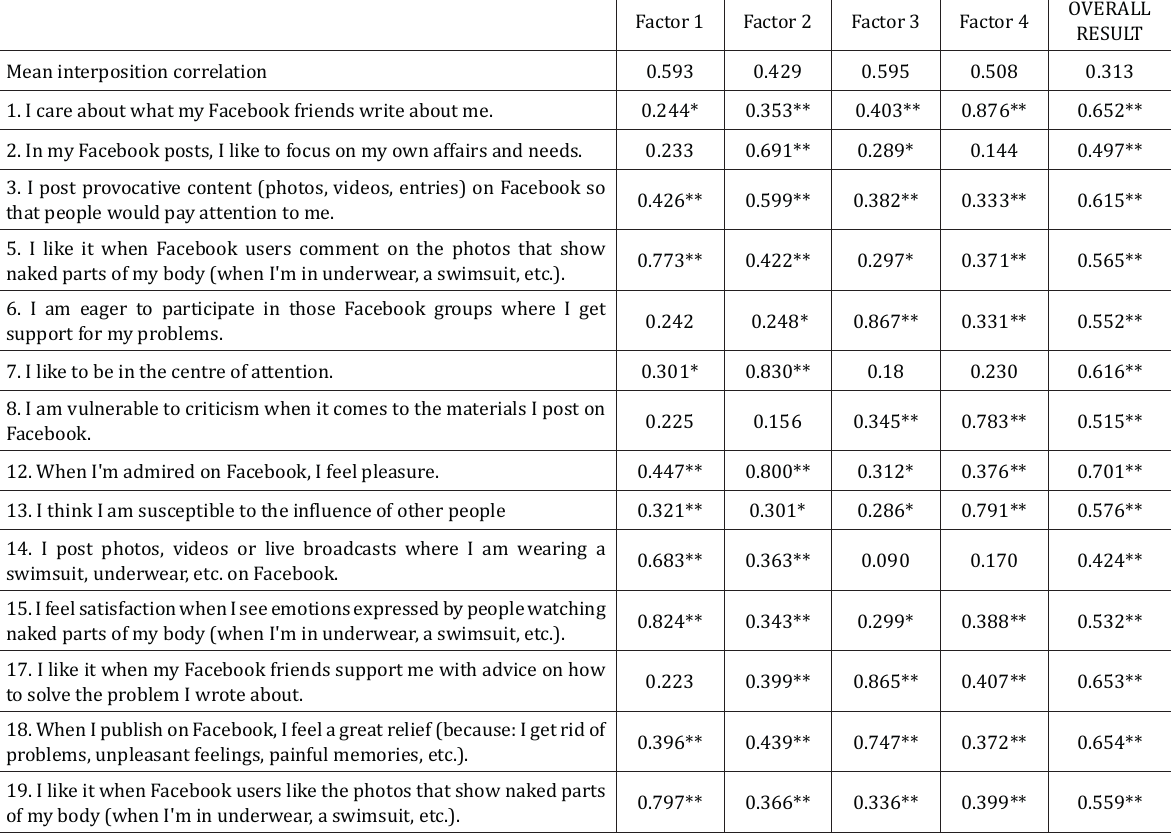
Table 3. The analysis of the correlation of the items with the identified factors and the overall result